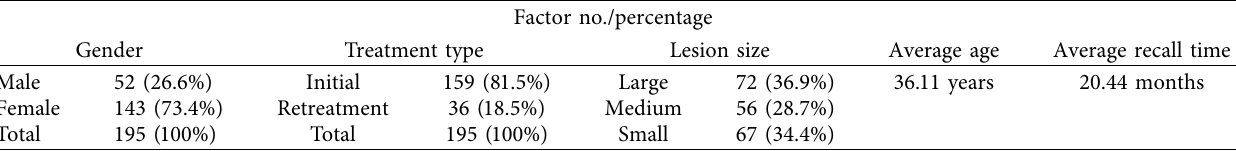
Table 1: Patients’ demographic data.